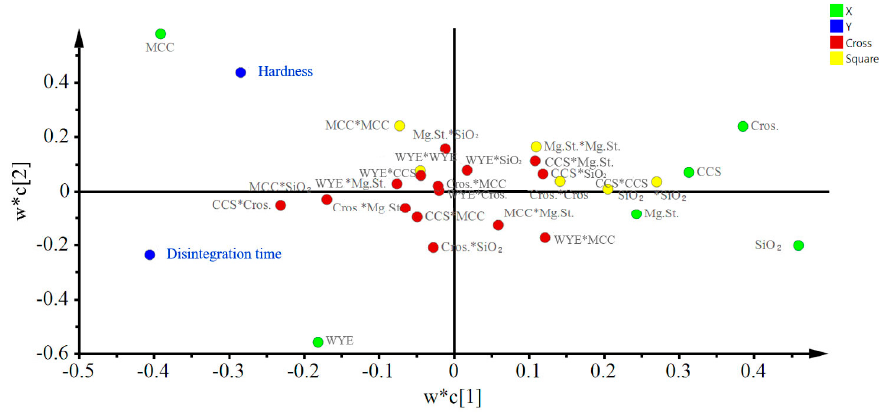
Figure 4. The variable importance in projection (VIP) plot ( a ) displaying important variables in terms of disintegration time and hardness; and coefficient plots for ( b ) disintegration time; and ( c ) hardness.